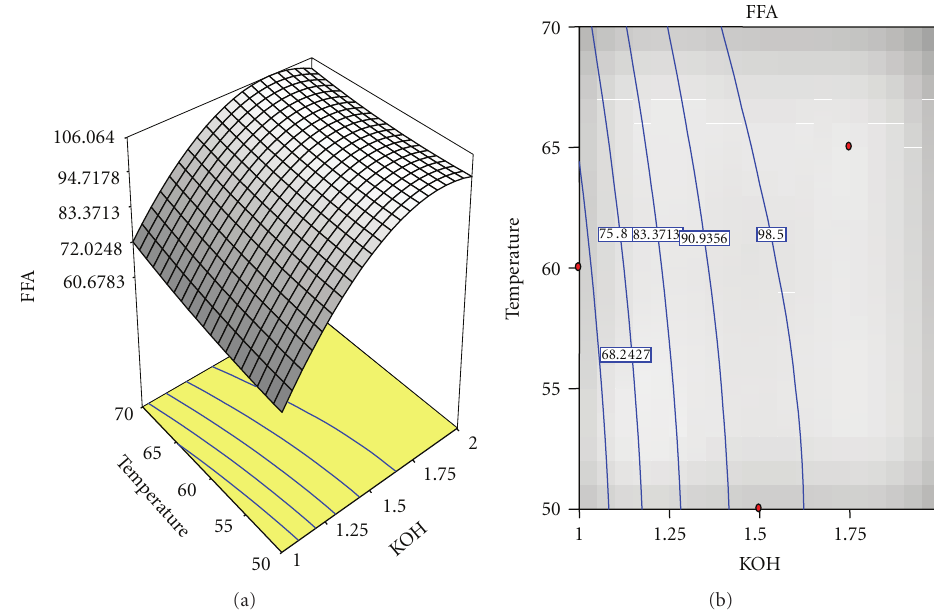
Figure 1: Response surface (a) and contour plots (b) for the e ff ect of the ethanolic KOH ( X 1 , w) and reaction temperature ( X 2 , ◦ C) on the FFA%.